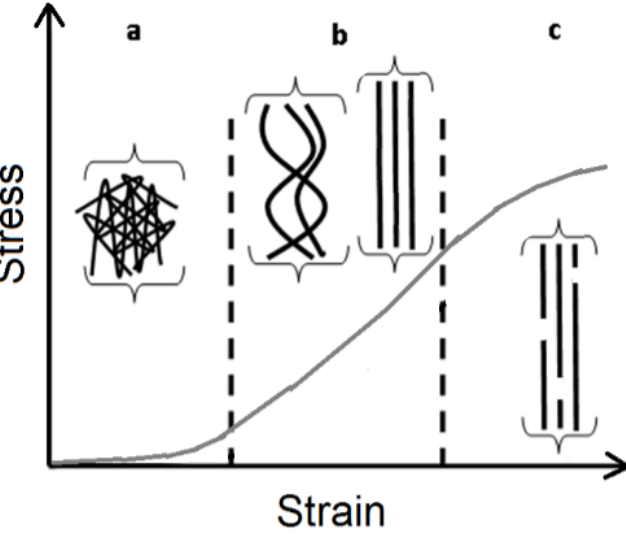
Figure 1. The stress-strain relationship of the skin is associated with collagen orientation. ( a ) The collagen fibrils are randomly aligned and readily orient with the application of small amounts of stress (low elastic modulus); ( b ) The collagen fibrils begin to straighten and gradually align in the direction of the applied stress. At the end, almost all collagen fibrils are aligned in the direction of loading; ( c ) Damage begins to accumulate due to sliding of fibrils past one other, among many other mechanisms. Figure adapted from Brinckmann [1] and Daly